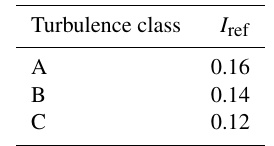
Figure 2. The dots correspond to the 10min standard deviation of the wind speed as a function of U at a height of 100m over a 10- year period. The black and blue curves show the IEC extreme tur- bulence model for class C and class B, respectively. The selected events (blue dots) are σ u values exceeding the extreme turbulence model class B. Table 1. The IEC turbulence classes and associated turbulence in-